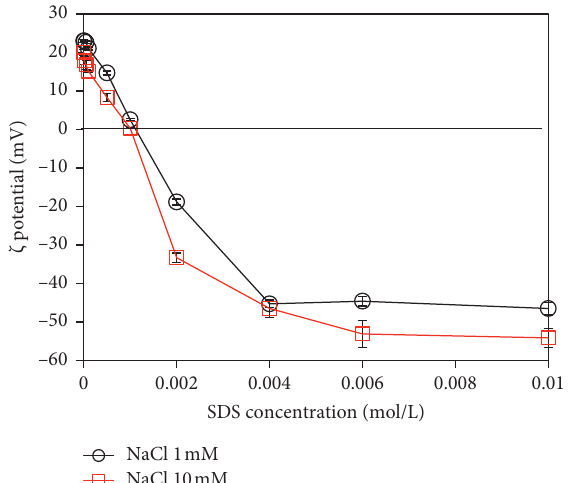
Figure 1: The ζ potential based on adsorption isotherms of the SDS onto α -Al 2 O 3 nanoparticles at pH 5.0 and under different ionic strengths of 1 and 10mM NaCl. The standard deviation was taken by the three different measurements.